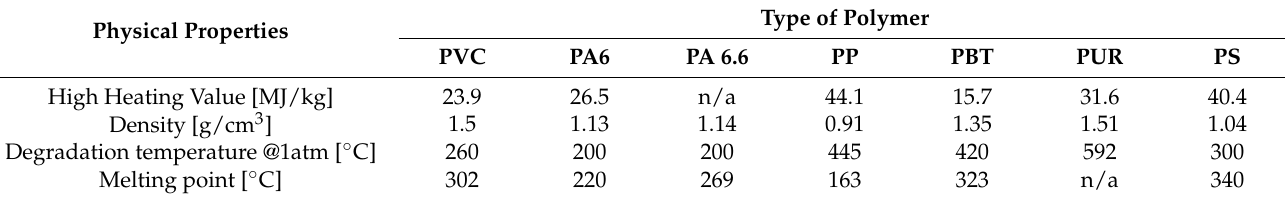
Table 1. The physical and chemical properties of selected polymers